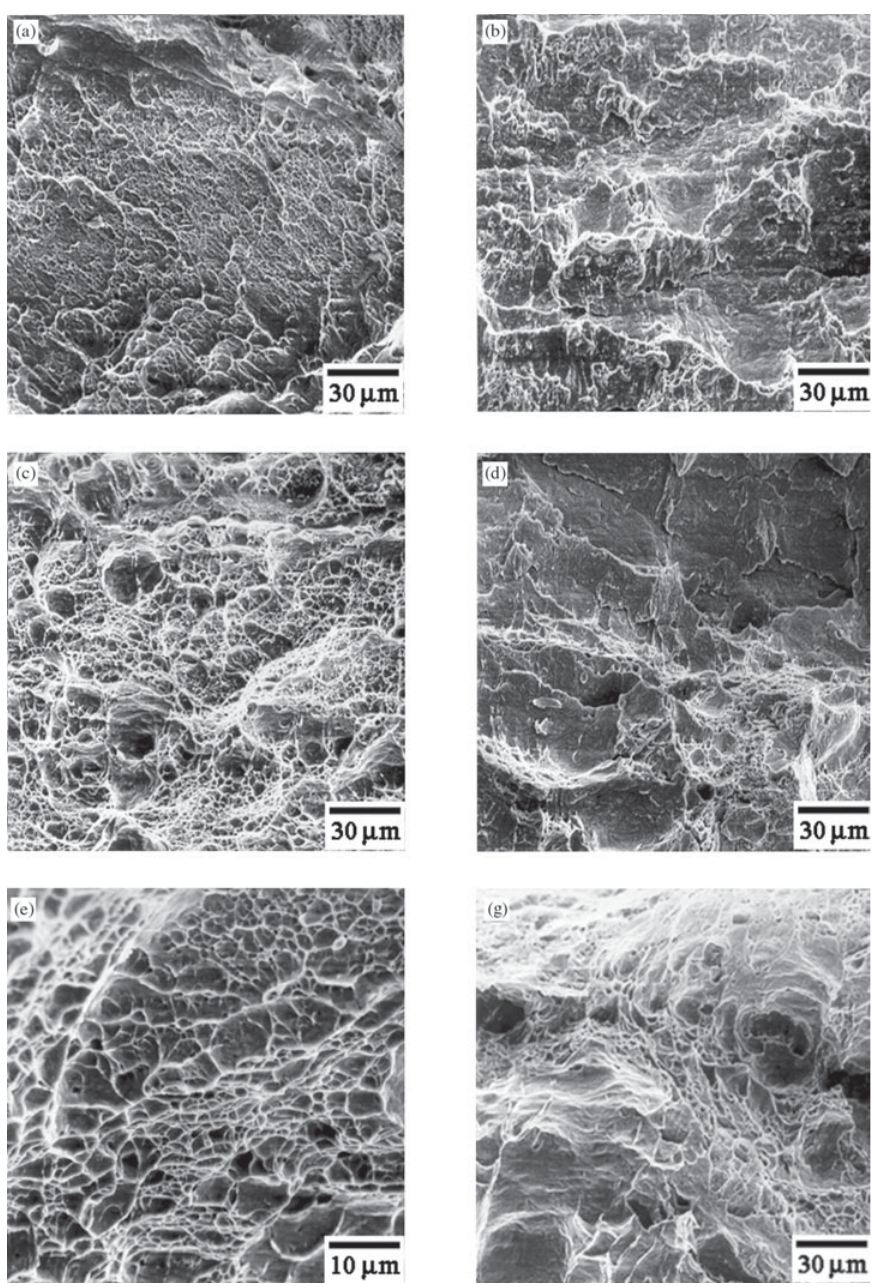
Figure 4. Fracture surfaces of impact Charpy specimens. A508 steel submitted to Q&T thermal cycles a) I , b) J , c) K , d) L and e) M . f) annealed H